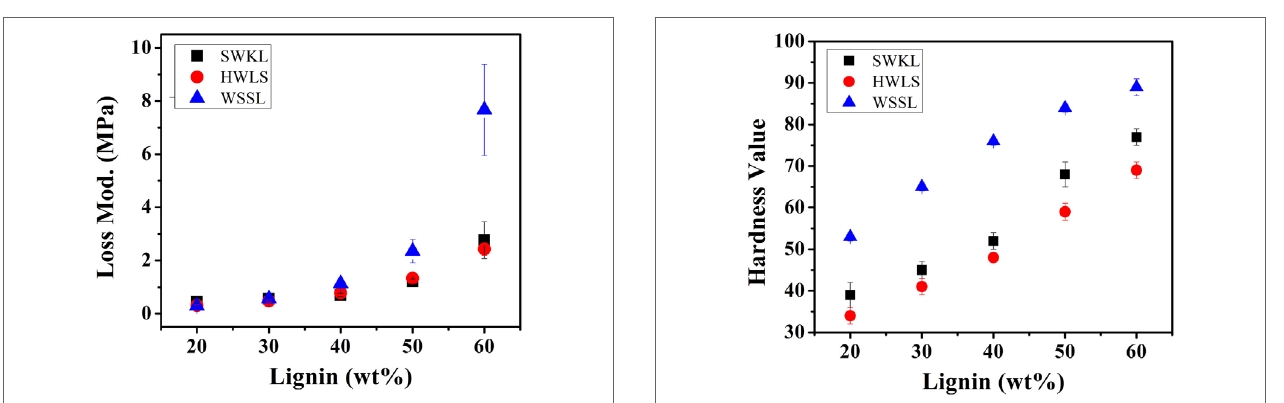
FigUre 8 | Shore hardness (Type A) results for all lignin-based polyurethane samples.